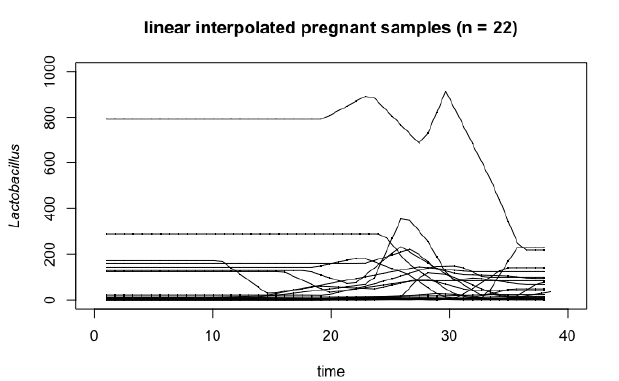
Figure 1. Linear interpolated Lactobacillus readings of 22 pregnant women over 38 weeks of pregnancy.